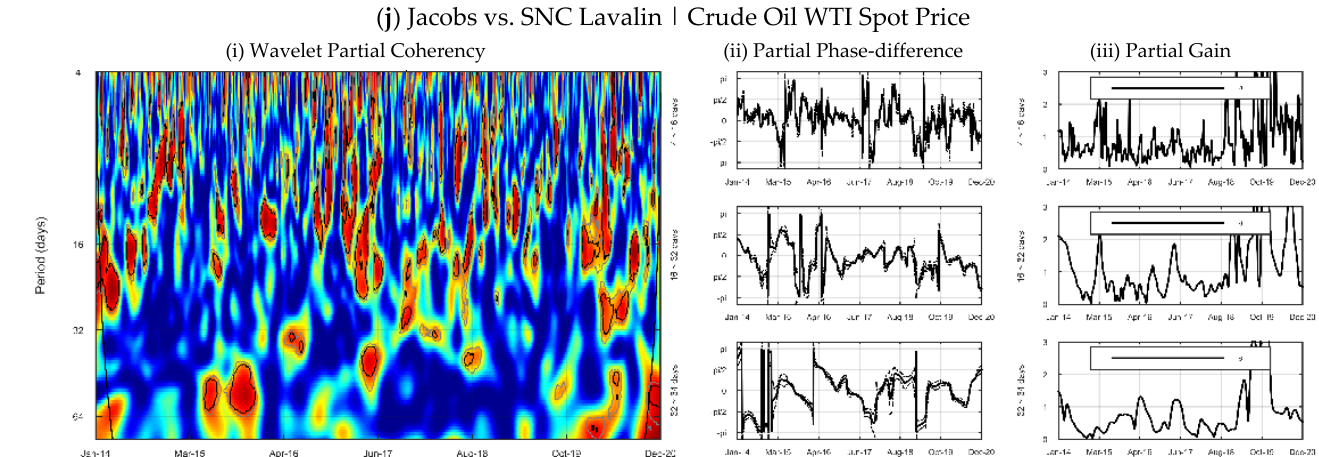
Figure 3. Partial wavelet coherency among the five largest consulting engineering companies. Notes: The cone of influence is shown as the black curve. The 5% significance level contours are in black, the 10% significance level contours are in gray. The significance level was derived from Monte Carlo Simulations with 1000 runs. Data from January 9, 2014 to December 9, 2020. Source: Investing.com and Federal Reserve Bank of St. Louis.